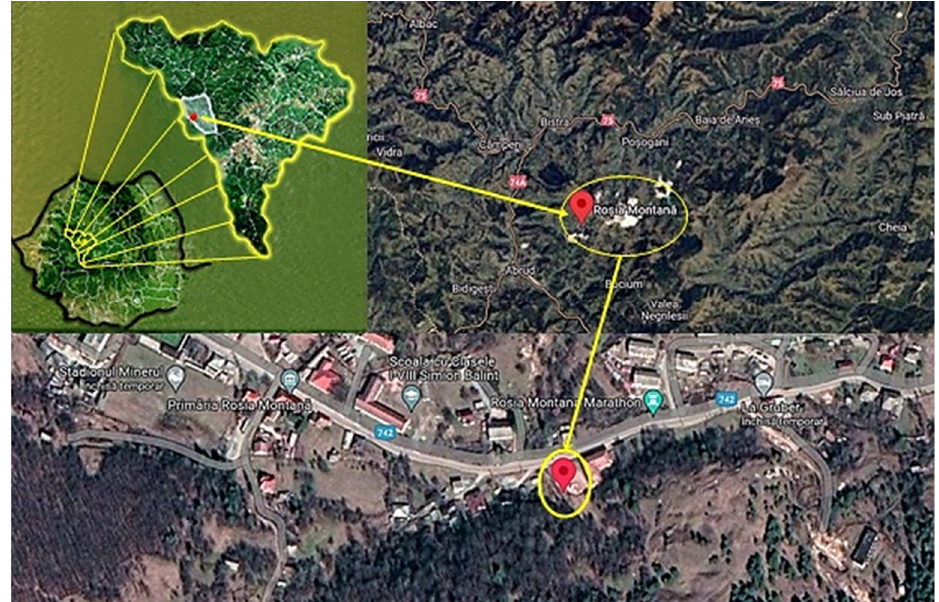
Figure 1. Location of the “Roșia Montană” gold mine gallery.